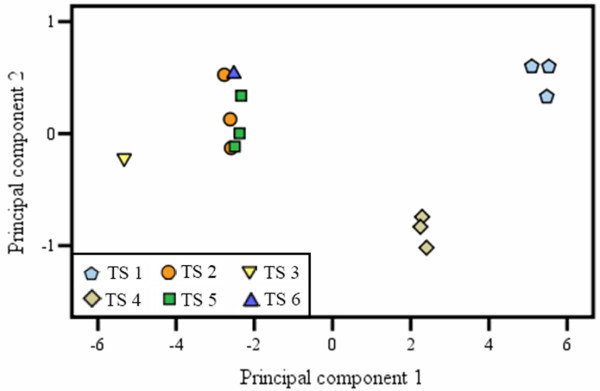
Principal component loadings of clouded leopard (Neofelis nebulosa) front left tracks. Track derived from front left pugmarks were taken in Tabin Wildlife Reserve, Sabah, Malaysia. Different symbols indicate tracks belonging to the same track set (TS).